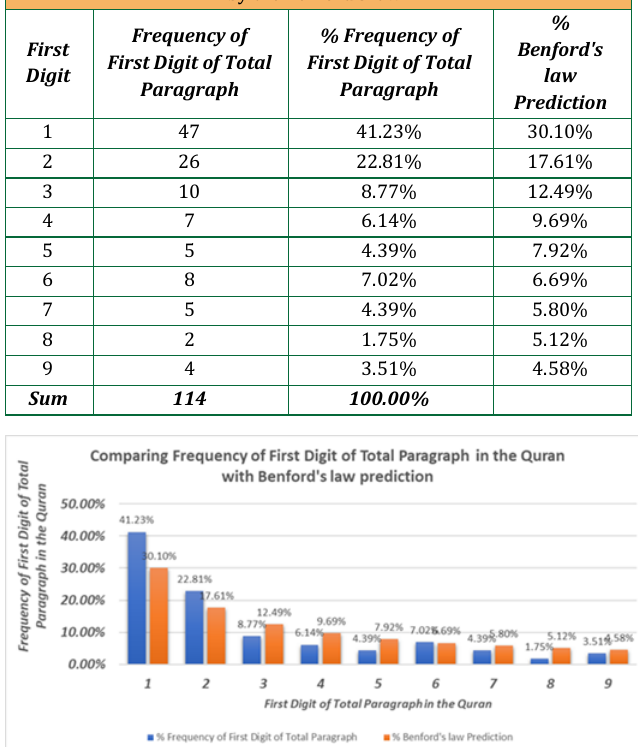
Table 2: Frequency percentage of first digit of total paragraph in the Quran is compared with frequency percentage of first digit predicted by the Benford’s law.